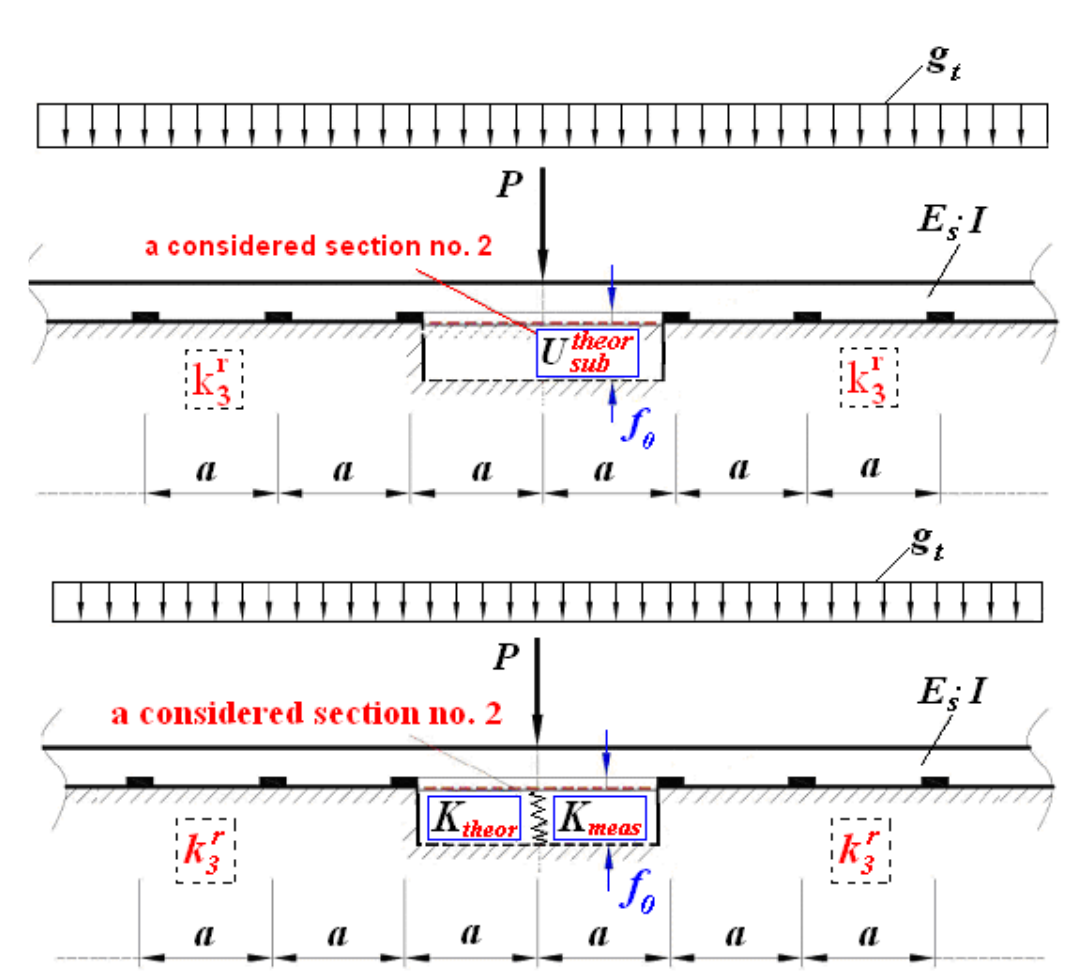
Figure 13. Exemplary assumed simplified schemes for an analysis of a generated irregularity in track deflection for the considered section no. 2 of the track (Figure 3).